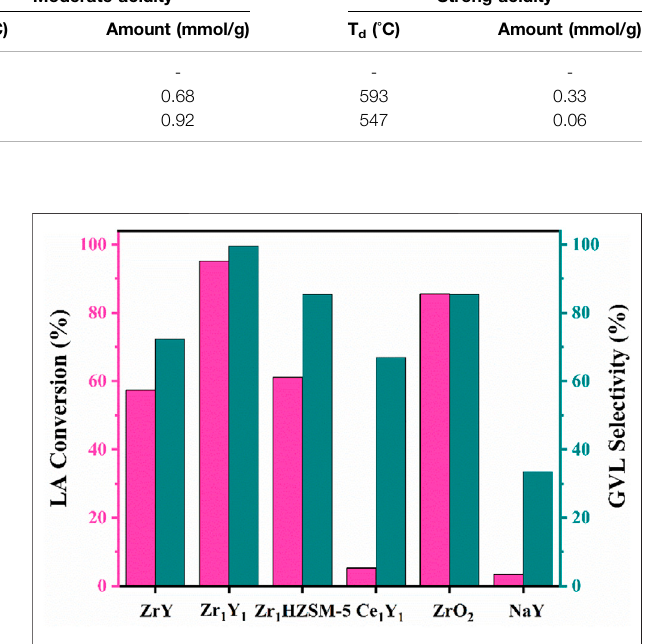
TABLE 1 | Acidity properties of NaY, Zr 1 Y 1 , and used Zr 1 Y 1 catalysts. Catalysts Weak acidity